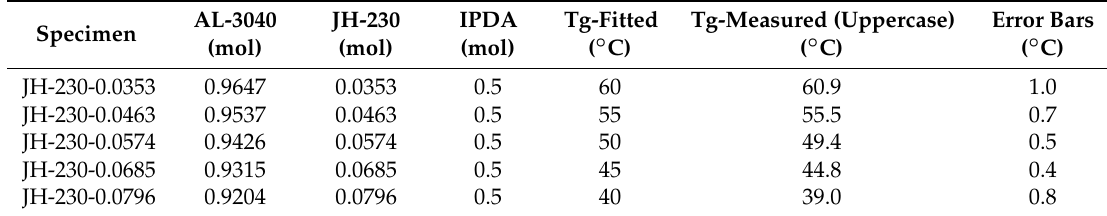
Table 3. Specimens with the second back-calculated formulations and their T g values.